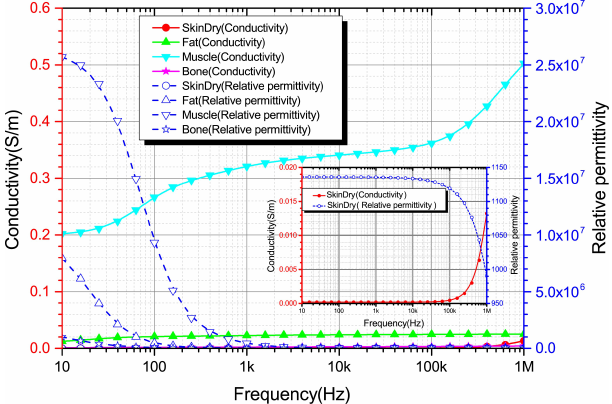
Figure 6. Conductivity and relative permittivity of the human tissues